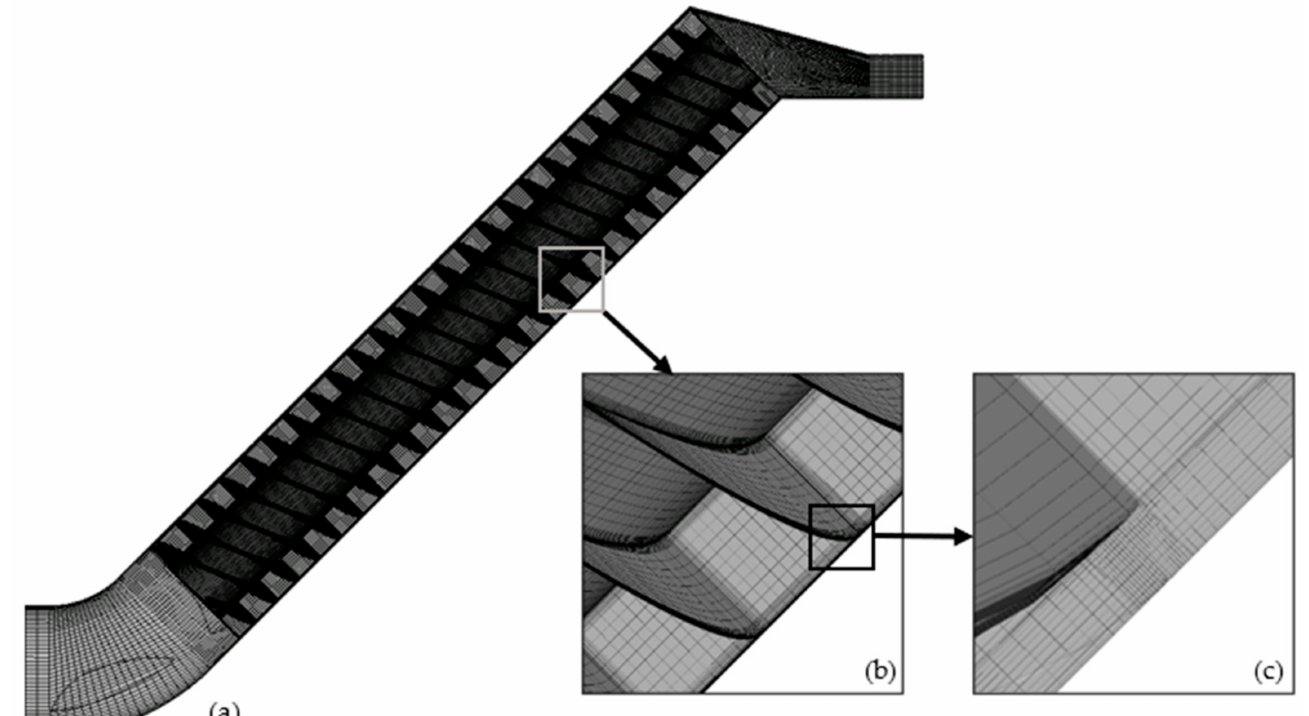
Figure 5. Hexagonal mesh for AST fluid domains in Ansys ICEM. ( a ) cross-section of AST mesh ( b ) near blade wall and near shaft wall mesh refinement ( c )mesh refinement of leakage